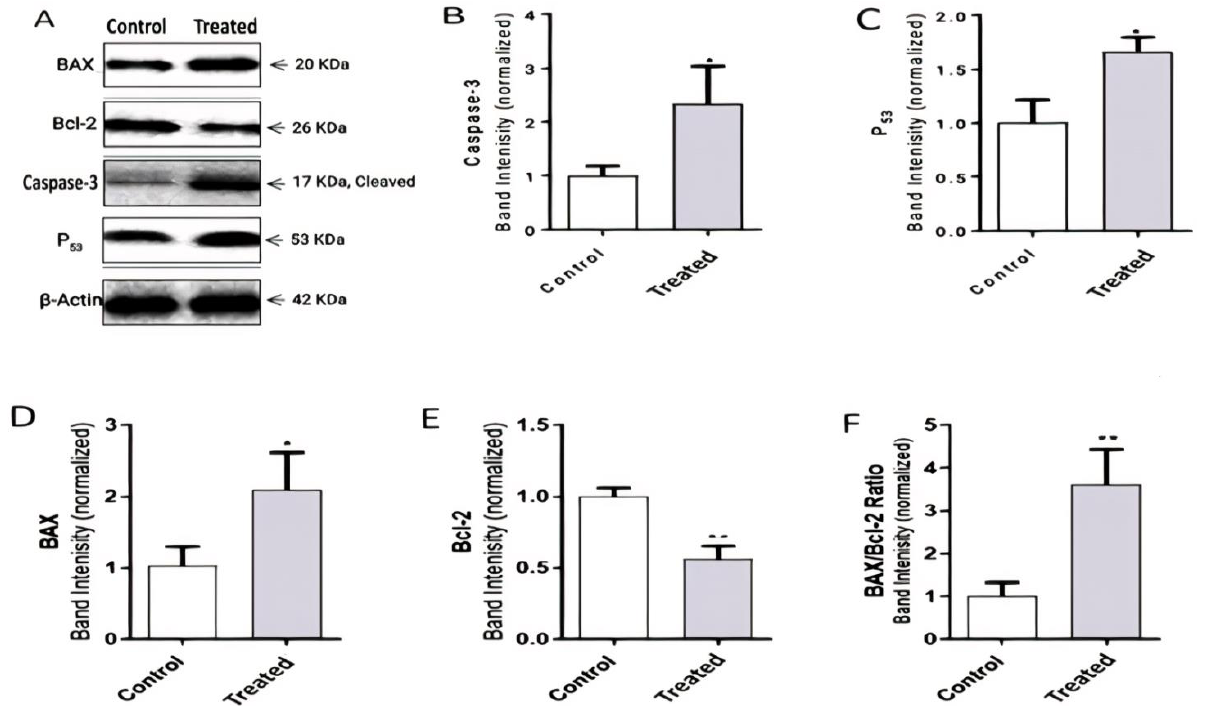
Figure 5. Western blot analysis. ( A ) shows western blot results about the expression level of apoptosis-related proteins BAX, Bcl-2, caspase-3, and p53 in HepG2 cells after being treated for 48 h with IC 50 concentration of R. nomadica venom. From ( B – F ) represent the statistical graphs of the density ratios of the proteins calculated by ImageLab. Protein levels were normalized to β-Actin. Data are analyzed with paired Student’s t-test Values are represented as mean ± SEM. * denotes significance difference ( p < 0.05) vs. control. ** denotes significance ( p < 0.01) vs. control.